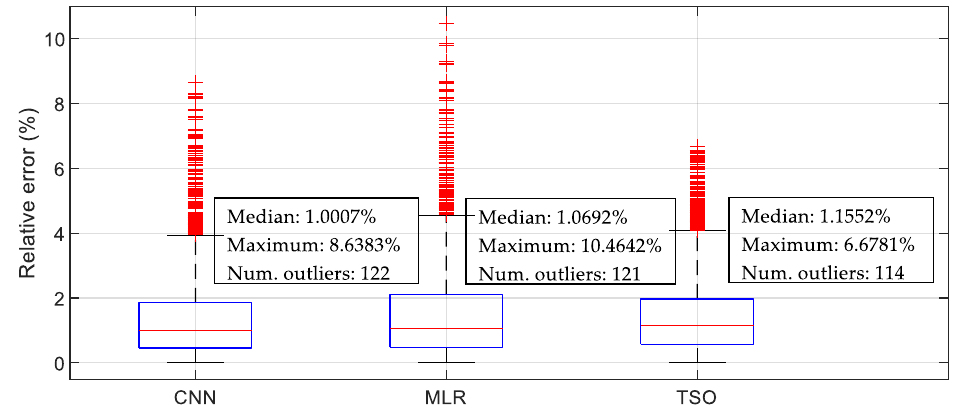
Figure 9. Boxplots of relative errors for Convolutional Neural Network (CNN), Multiple Linear Regression (MLR), and Transmission System Operator (TSO) forecast results.